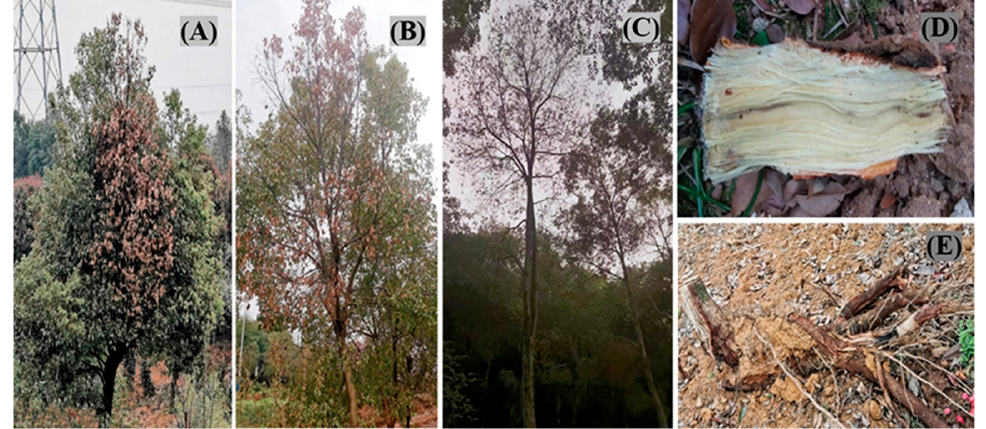
Figure 1. Symptoms of dieback and root rot disease on camphor ( Cinnamomum camphora (Linn) Presl). ( A – C ). Diseased tree and dead plants in the nursery land of Xuancheng city, Anhui, in 2021. ( D ). Xylem browning in diseased trees. ( E ). Root rot of diseased trees.